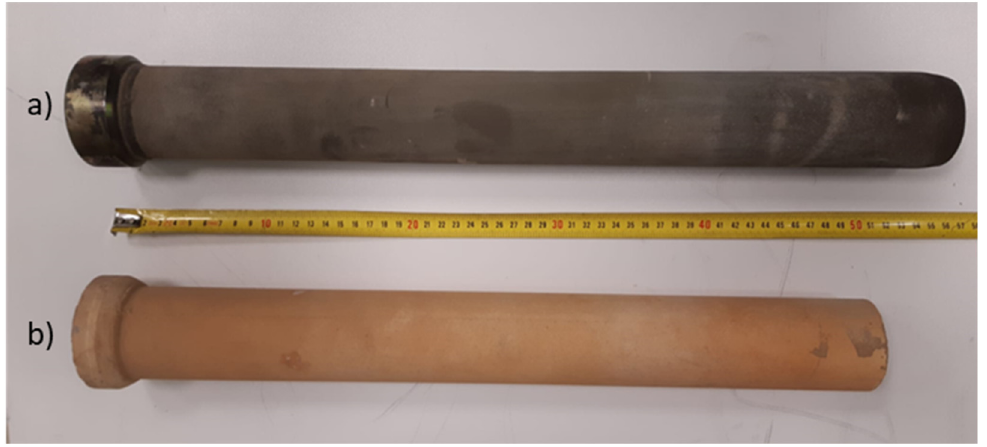
Figure 1. Metallic ( a ) and ceramic ( b ) filter candles.